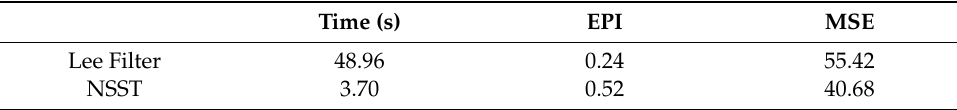
Table 2. Measured parameters of different filtering algorithm.